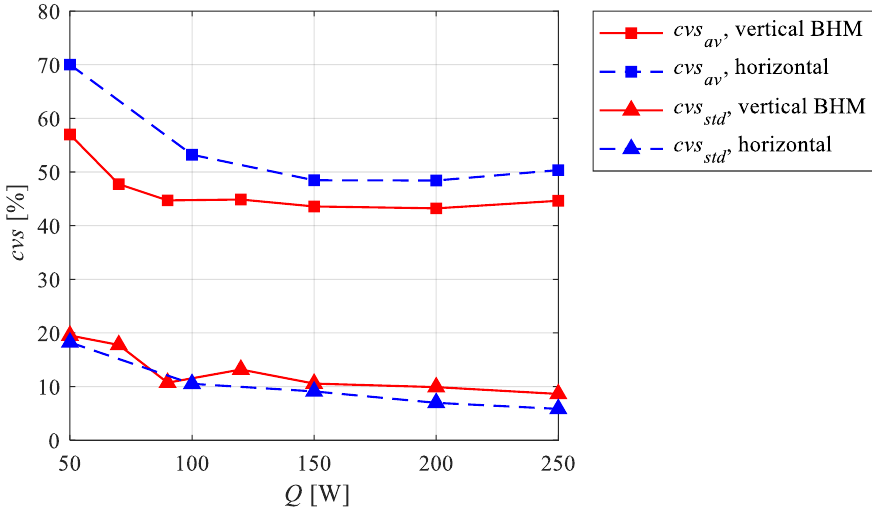
Figure 14. cvs av and cvs std, as functions of the heat load for the two considered orientations.